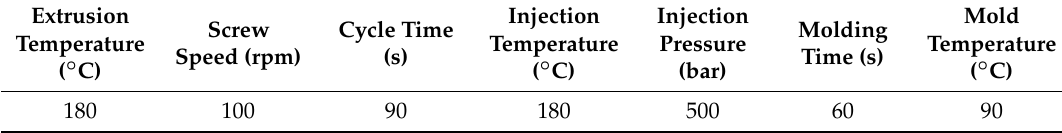
Table 1. Operating condition use for the extrusion and injection molding process.